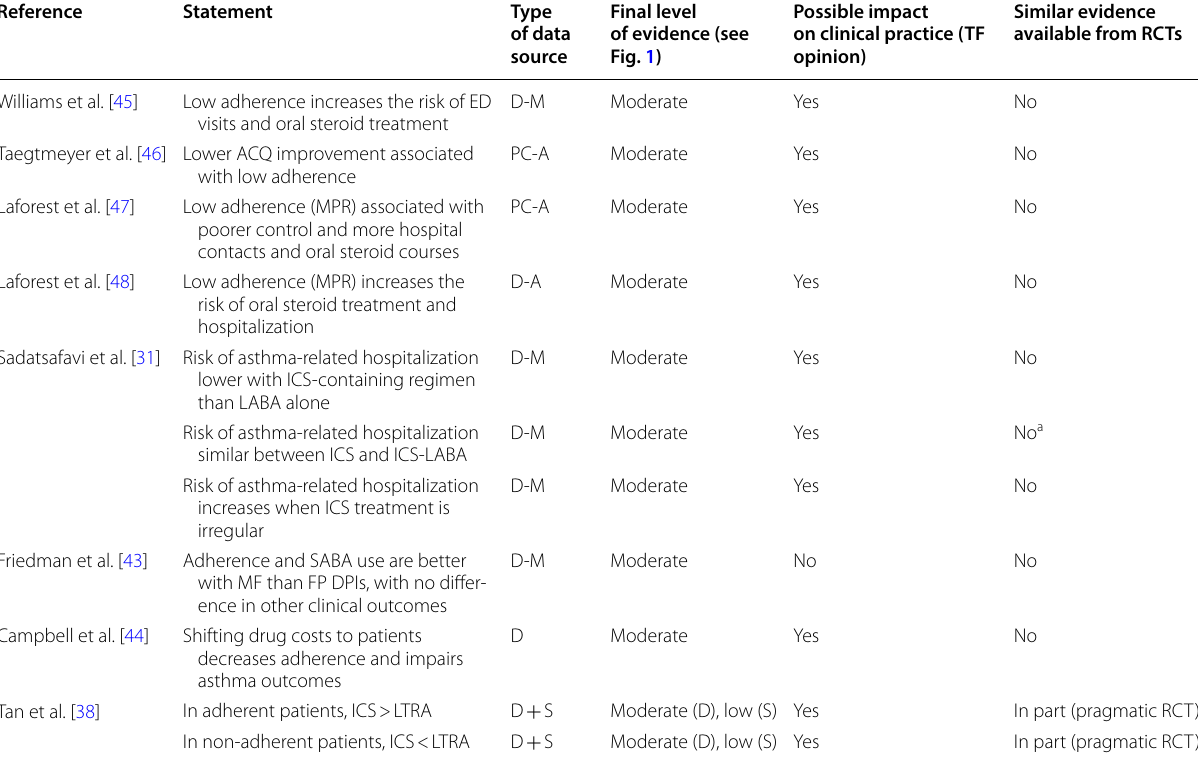
Table 3 Summary table of literature analysis, PICOT question 1: influence of adherence to ICS therapy on asthma outcomes